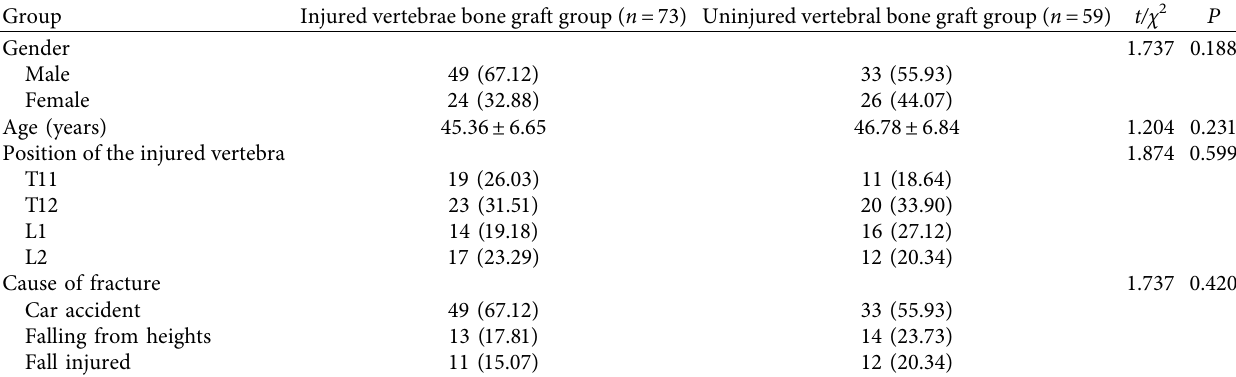
Table 1: Comparison of general data of patients with thoracolumbar fractures between the two groups ( X ± S ).